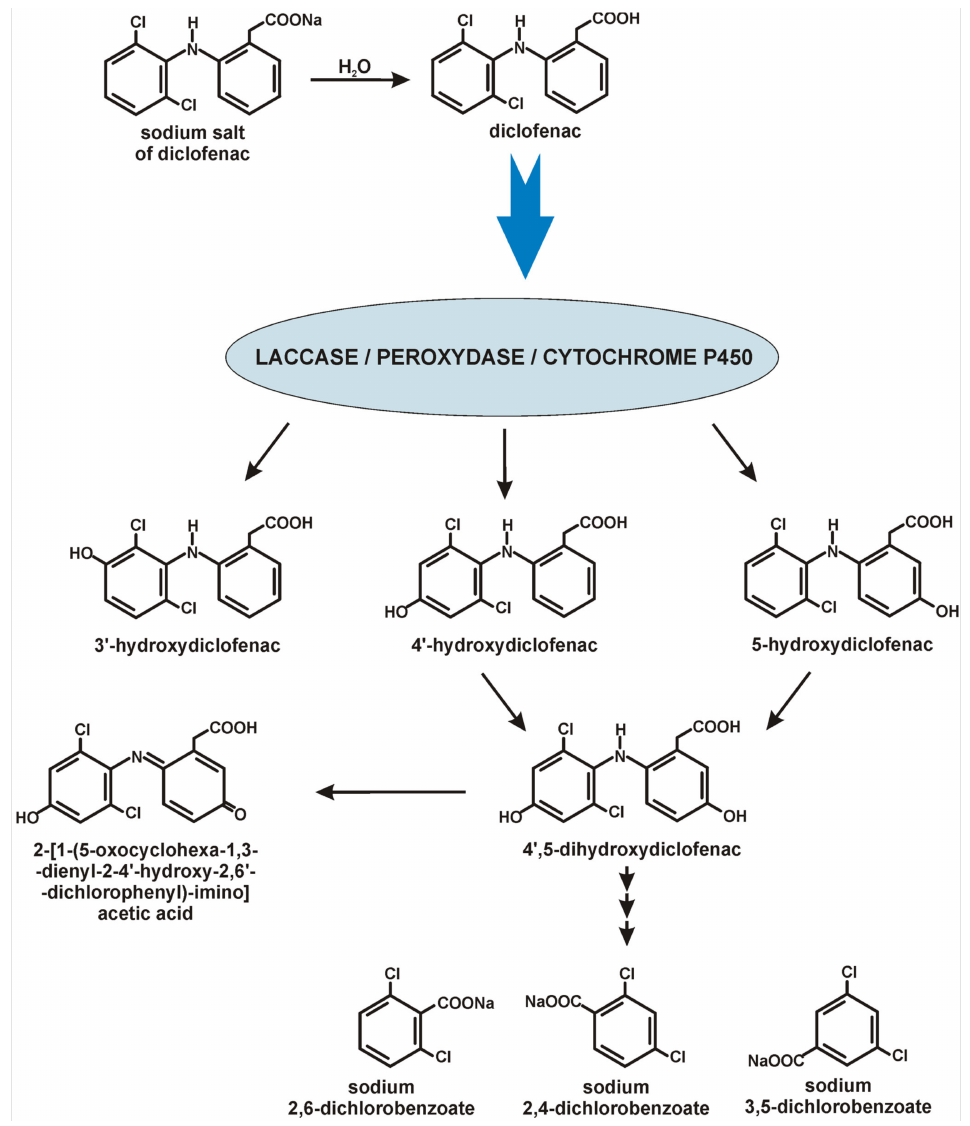
Figure 1. Diclofenac biotransformation by fungi